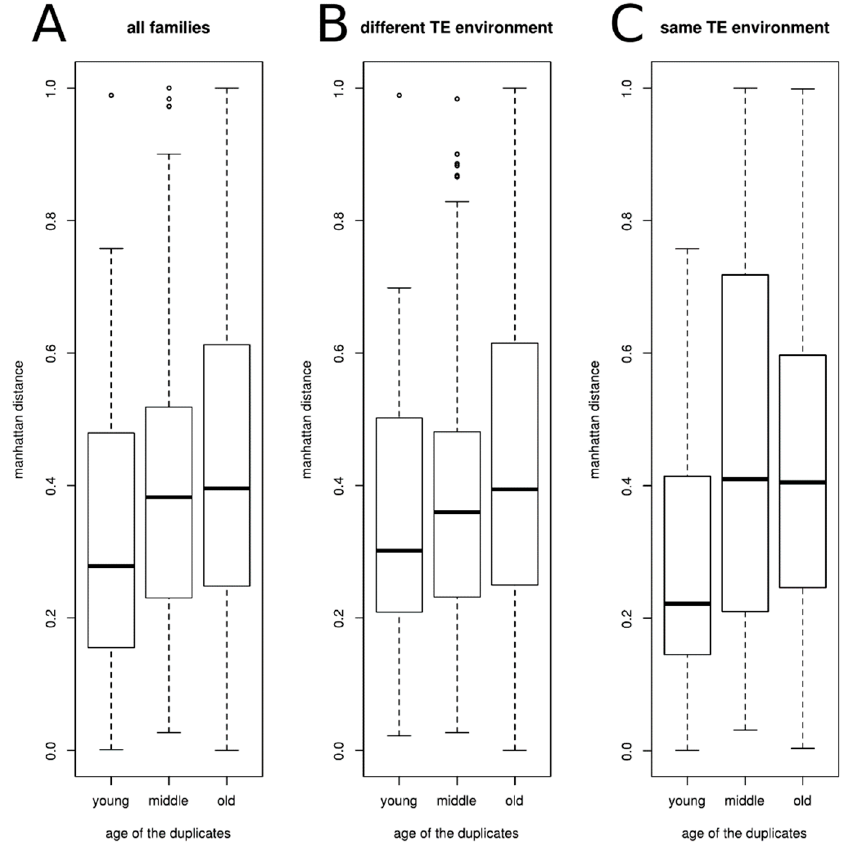
Figure 5. Average Manhattan distance of the duplicated gene expression level inside each class of ages, ( A ) for all families (Kruskal-Wallis chi-squared = 15.789, df = 2, p -value = 0.0003727), ( B ) for families whose two genes have different TE environment (Kruskal-Wallis chi-squared = 7.8622, df = 2, p -value = 0.01962), ( C ) for families whose two genes have the same TE environment (Kruskal-Wallis chi-squared = 10.421, df = 2, p -value = 0.00546).